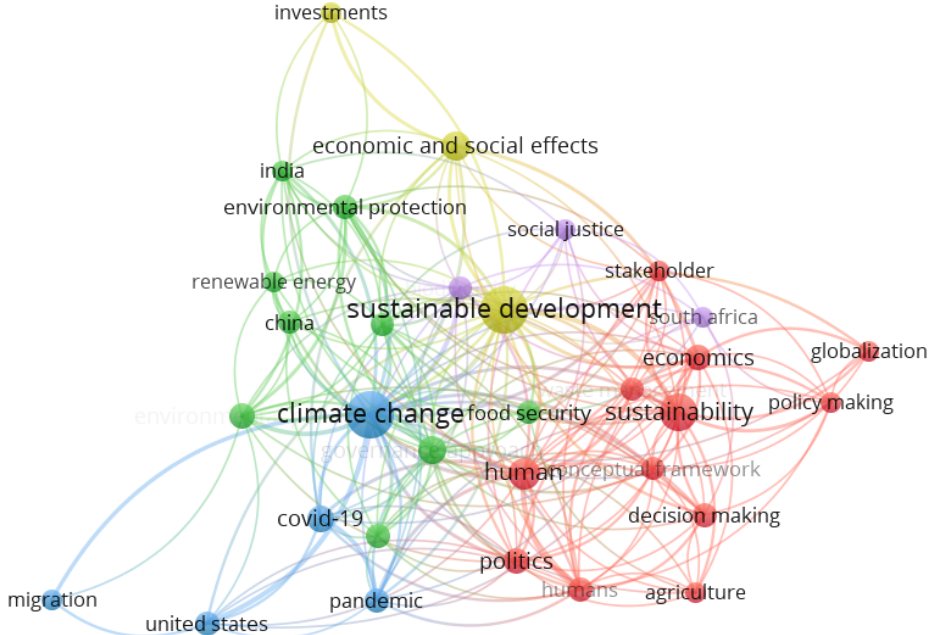
Figure 8. Co-occurrence of keywords during the period 1 January 2020–22 June 2022. (187 documents, occurrences ≥ 5; 5 clusters, 32 keywords).